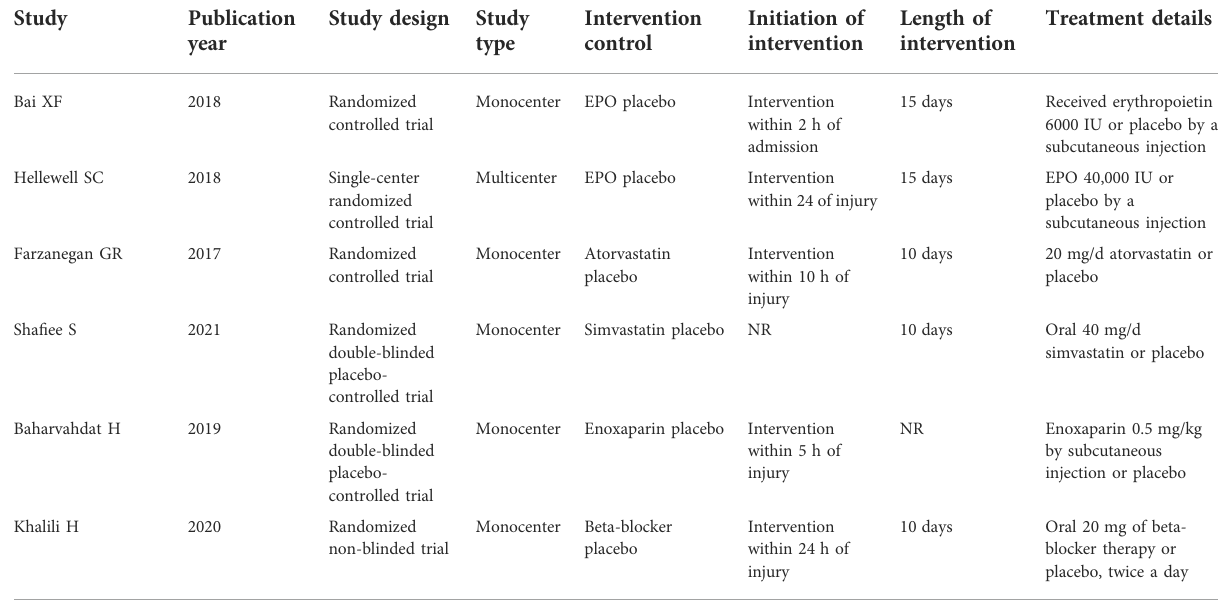
direct comparison evidence. The size of dots in the fi gure represents the sample size, and the thickness of lines represents the number of studies. No direct comparative evidence was found in the trials included in this study. The drug treatment schemes were indirectly compared using placebo as a medium, including 13 interventions: TXA, EPO, progesterone, progevitamin + vitamin D, atorvastatin,